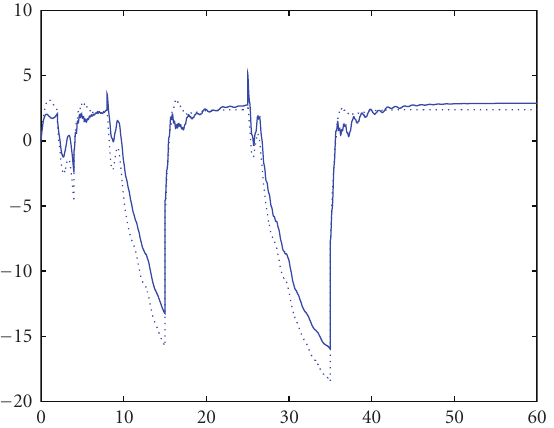
Figure 9: Step response of original switched linear system (solid line) and the reduced-order model which is of order 14